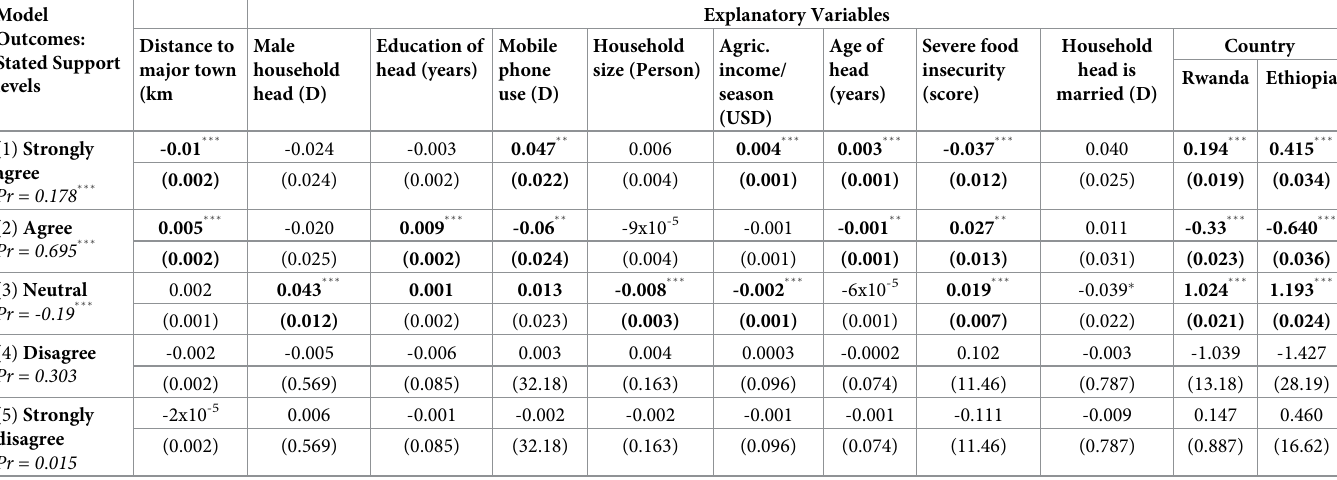
Table 7. Marginal effects after generalized ordered logit for support on CBE